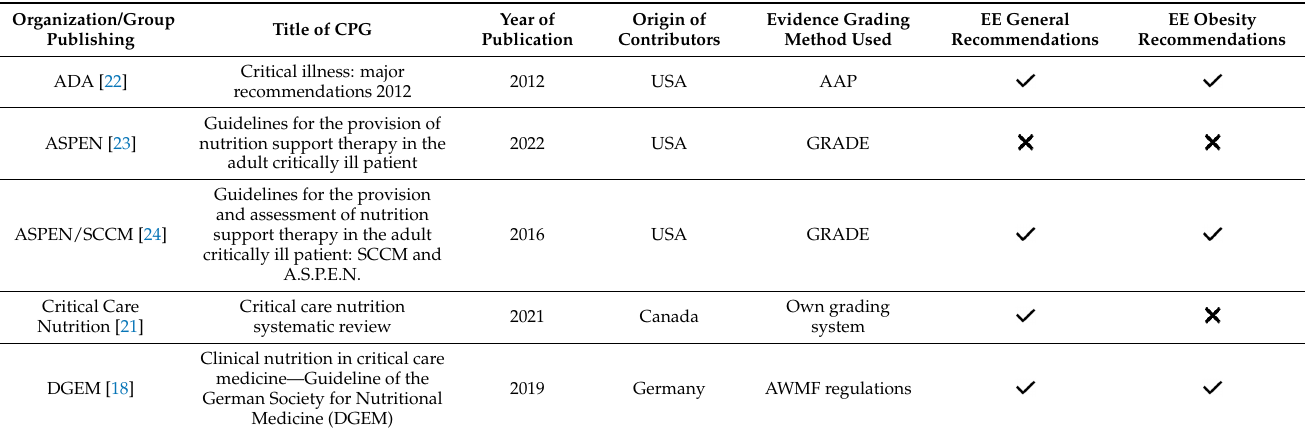
Table 1. Characteristics of included clinical practice